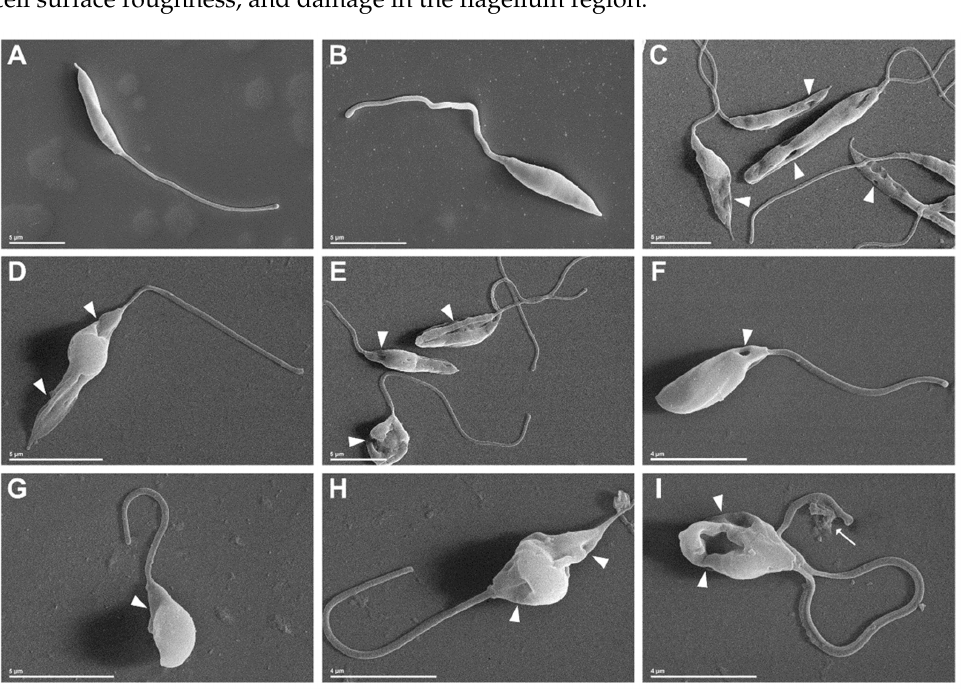
Figure 6. Morphological alterations in promastigotes of L. amazonensis treated with IC 50 3.3 μ M and 2× IC 50 6.6 μ M of 4f for 24 h, analyzed by scanning electron microscopy (SEM). ( A ) untreated promastigotes, ( B ) promastigotes treated with vehicle (DMSO 0.01%), ( C – F ) promastigotes treated with IC 50 3.3 μ M of 4f , ( G – I ) promastigotes treated with 2× IC 50 6.6 μ M of 4f . (white arrow) damage in the flagellum region (white arrowhead) plasma membrane damage. Scale bars = 5 μ m ( A – E , G ) and 4 μ m ( F , H , I ).